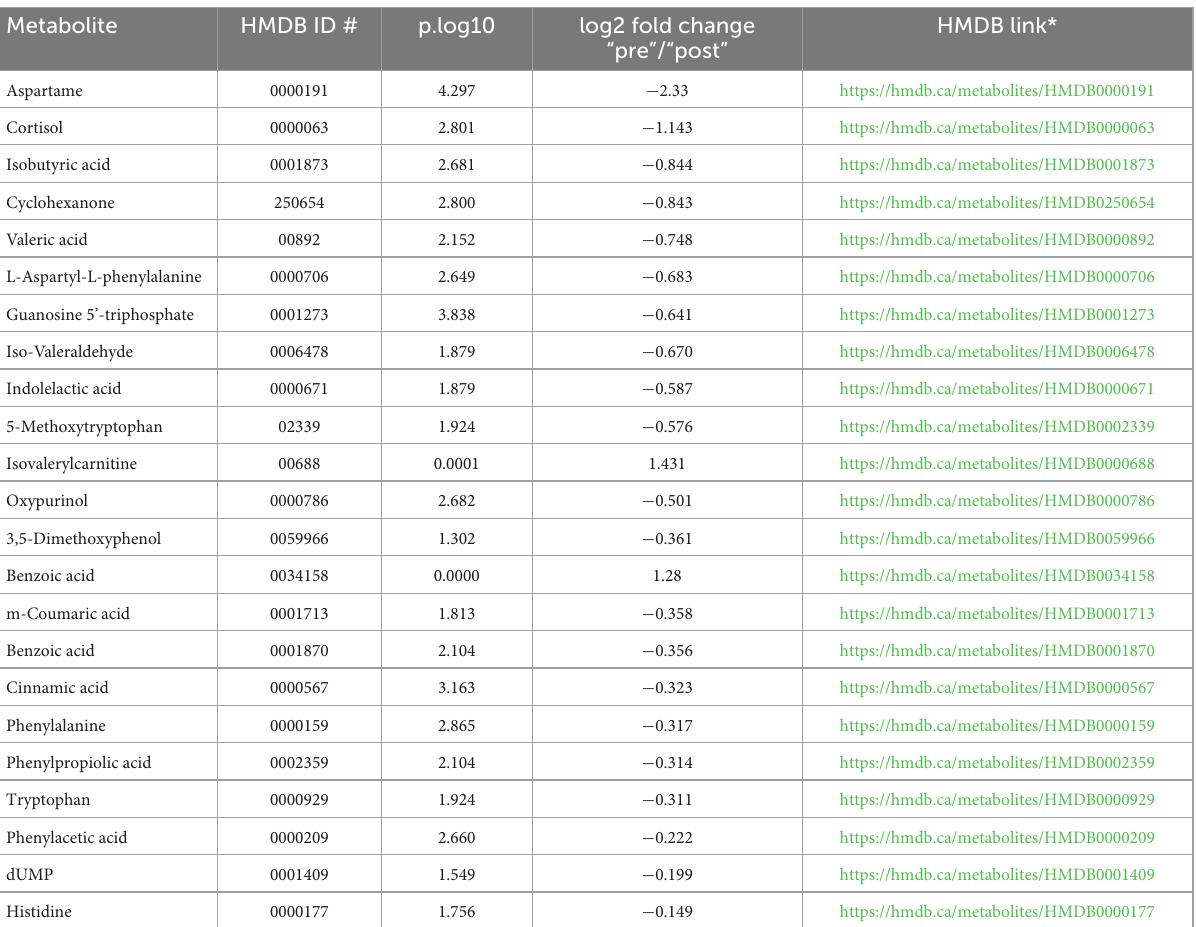
TABLE 3 Summary of metabolites that decreased after Ramadan